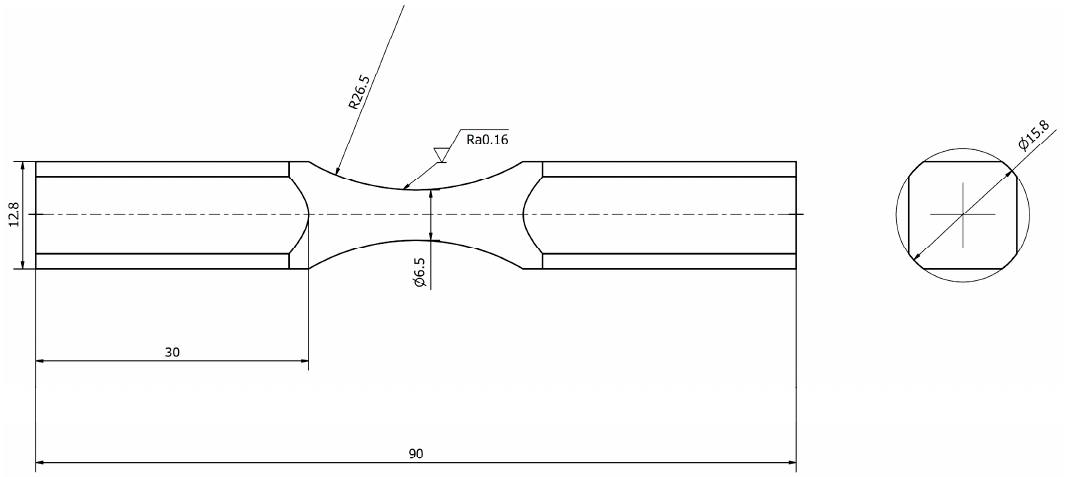
Figure 5. Shape and dimensions of a diabolo specimen made of 0H18N9 steel for fatigue tests.